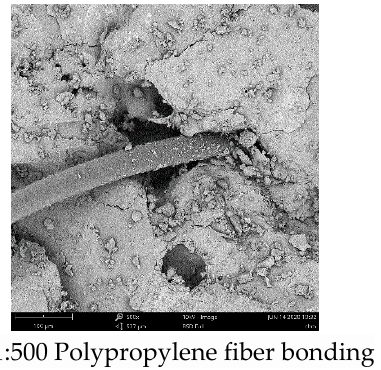
Figure 6. SEM of basalt fiber mortar.